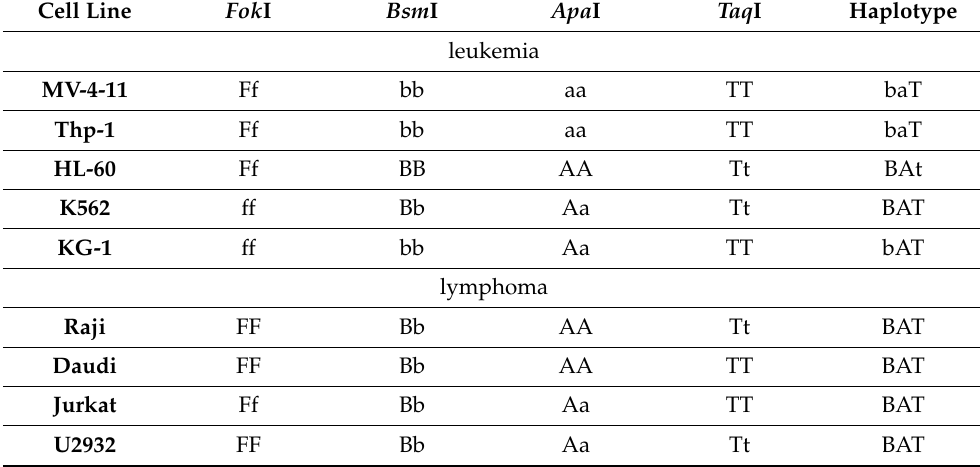
Table 2. The table shows alleles of human leukemia and lymphoma cells in the gene coding for the vitamin D